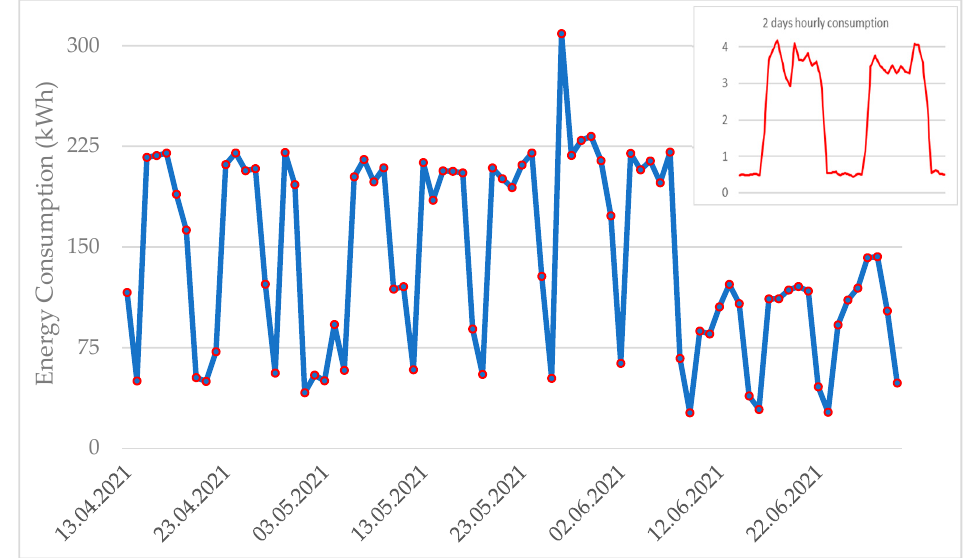
Figure 6. Daily energy consumption of the swimming pool complex. The consumption is measured every 15 min, every single point in the figure represents the sum of 96 measurements. In the zoomed area, hourly consumption for two days is shown, every four measurements are added to form the consumption of each hour in the day.